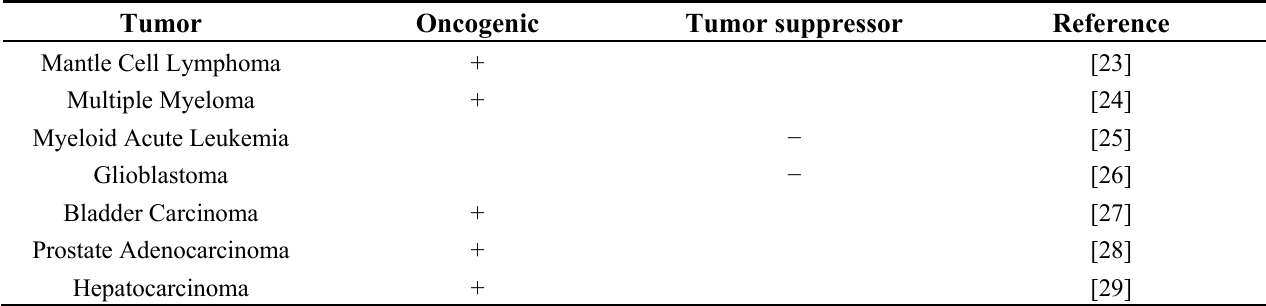
Table 1. Oncogenic and Tumor suppressor effects of TRPV2 expression in different